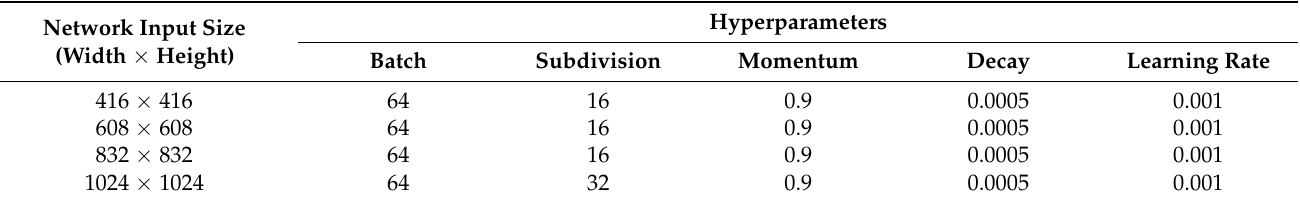
Table 3. YOLOv3 network input sizes and hyperparameters scenario for training and validation.